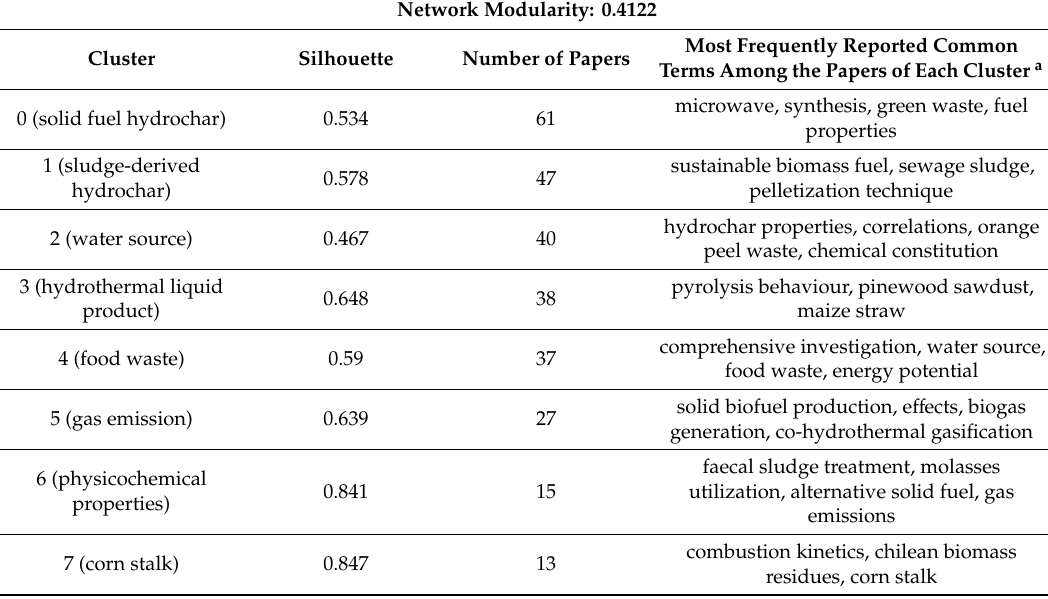
Table 1. Network modularity, cluster silhouette, the number of papers and the most frequently reported terms in the 2018–2020